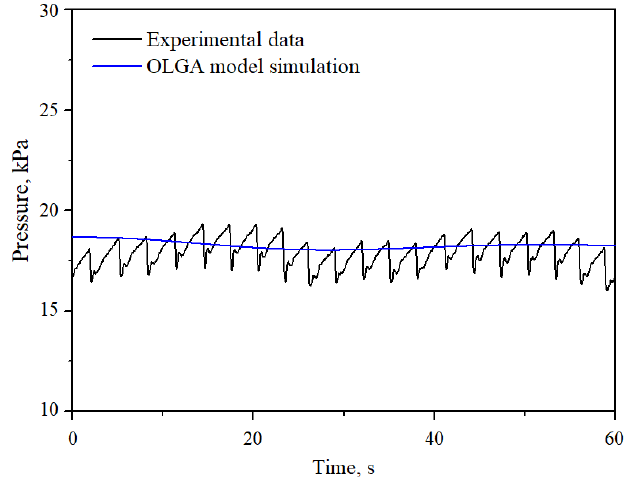
Figure 14. Measured and simulated riser-base pressure profiles of choking-induced bubbly flow ( U GS = 0.08 m/s and U LS = 0.09 m/s).